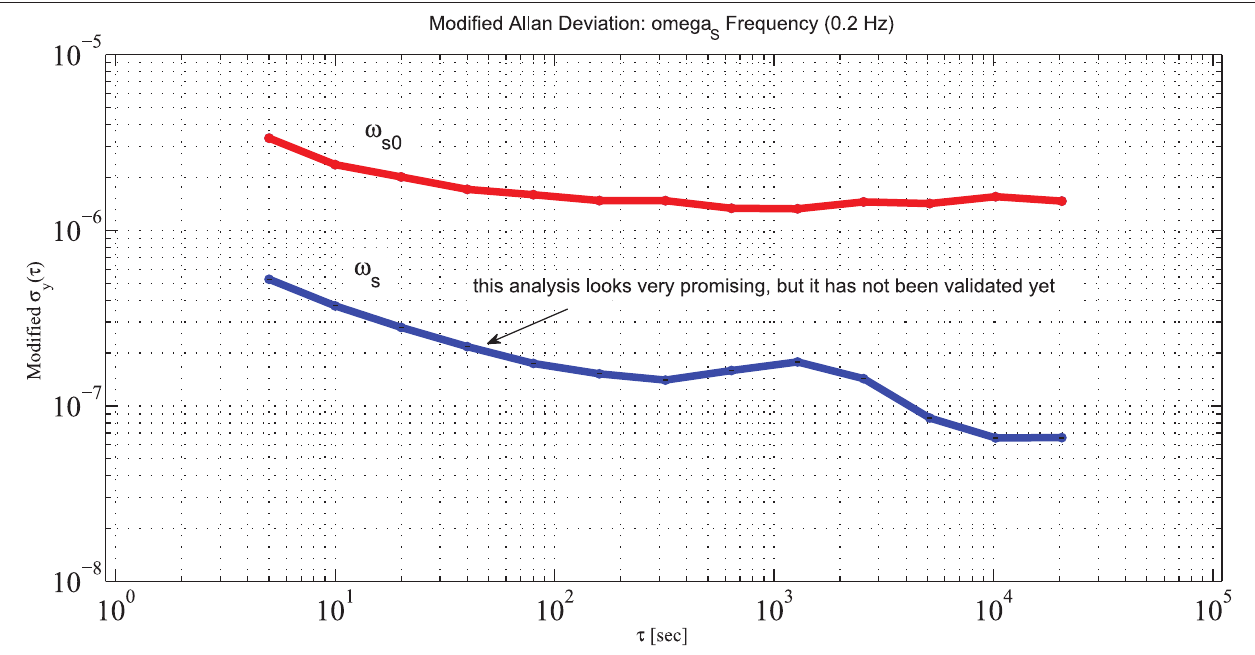
FIGURE 9 | Modified Allan Deviation of the evaluated ω s 0 and the ω s evaluated taking into account other terms induced by the laser dynamic; this analysis is still ongoing, and will be further investigated in the